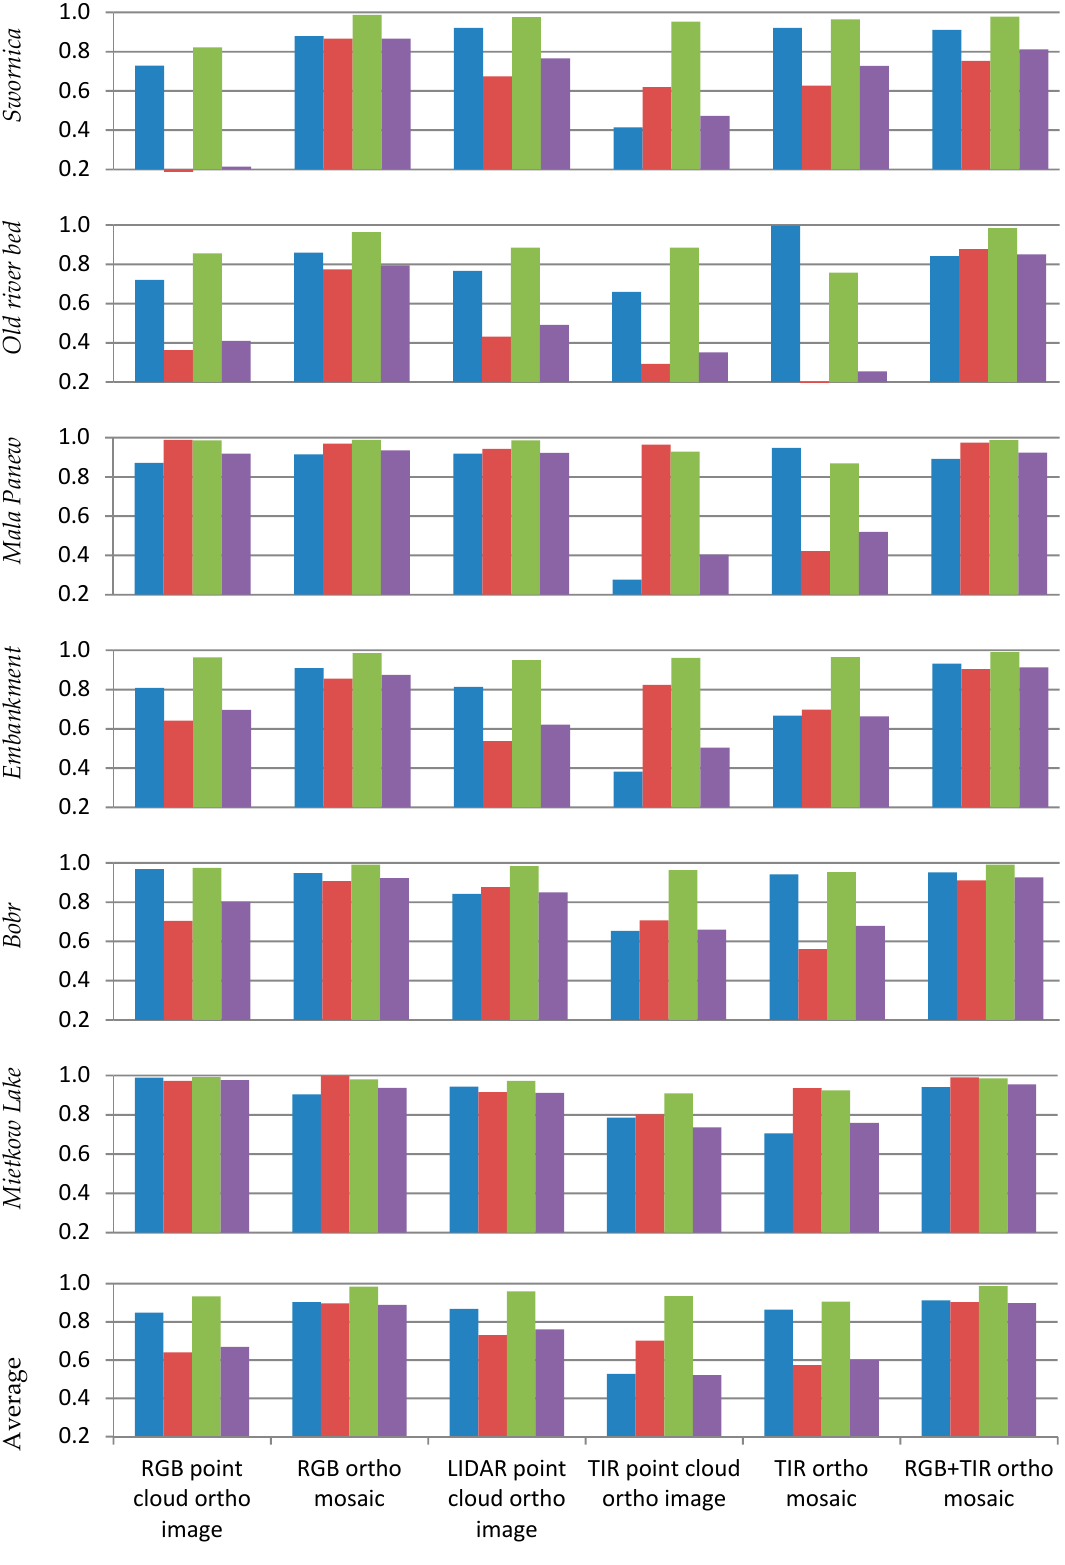
Figure 5. The quality of the class Water identification with respect to the test site and sensor-product (x axis): the bar colors are blue for user accuracy, red for producer accuracy, green for overall accuracy, and violet for kappa.